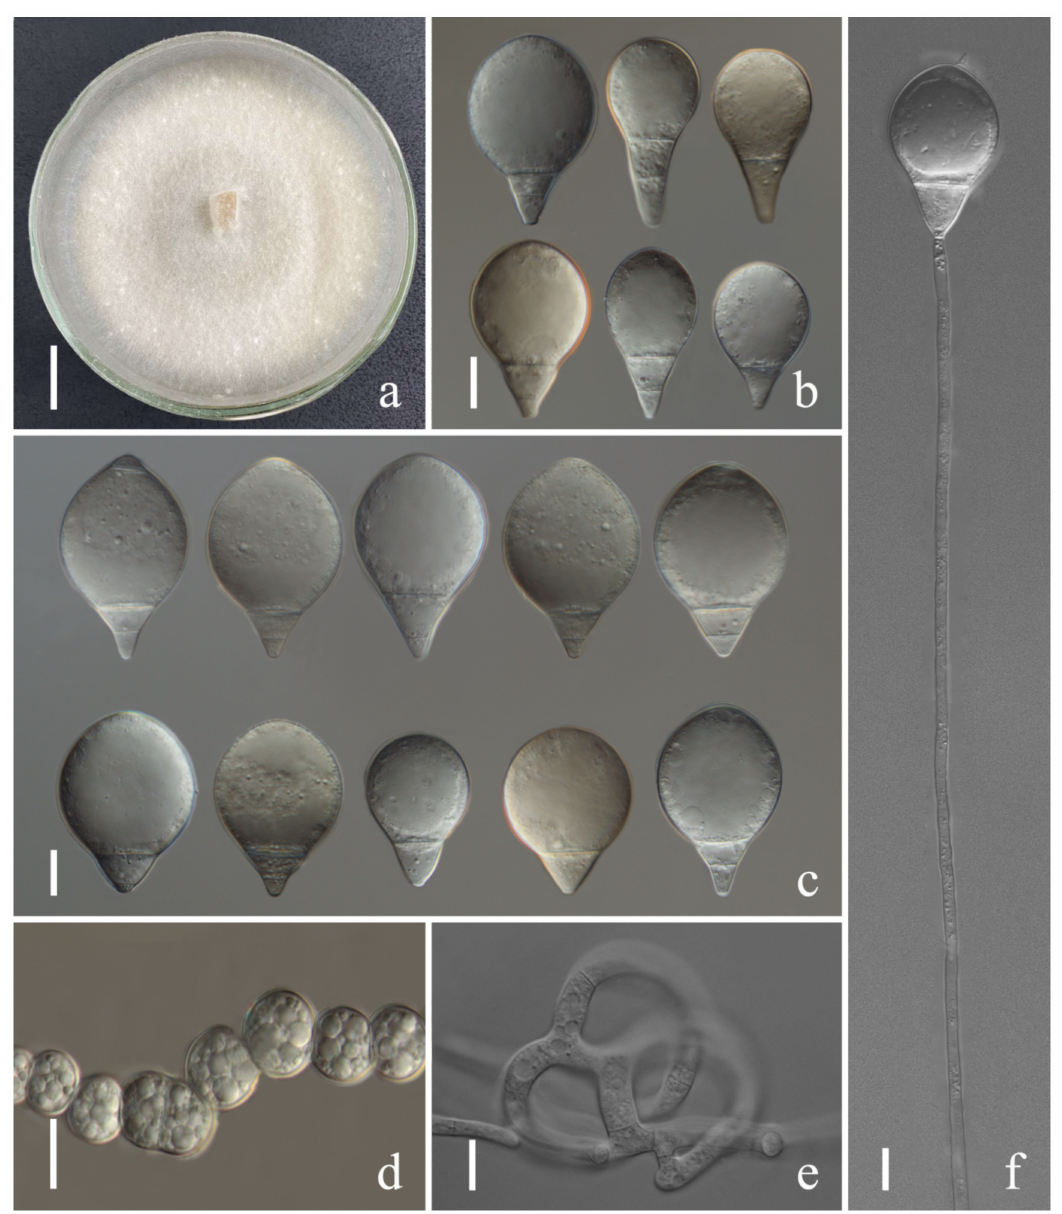
Figure 5. Arthrobotrys luquanensis (CGMCC3.20894). ( a ) Colony. ( b , c ) Conidia. ( d ) Chlamydospores. ( e ) Trapping device: adhesive networks. ( f ) Conidiophore. Scale bars: ( a ) = 1 cm, ( b – f ) = 10 µ